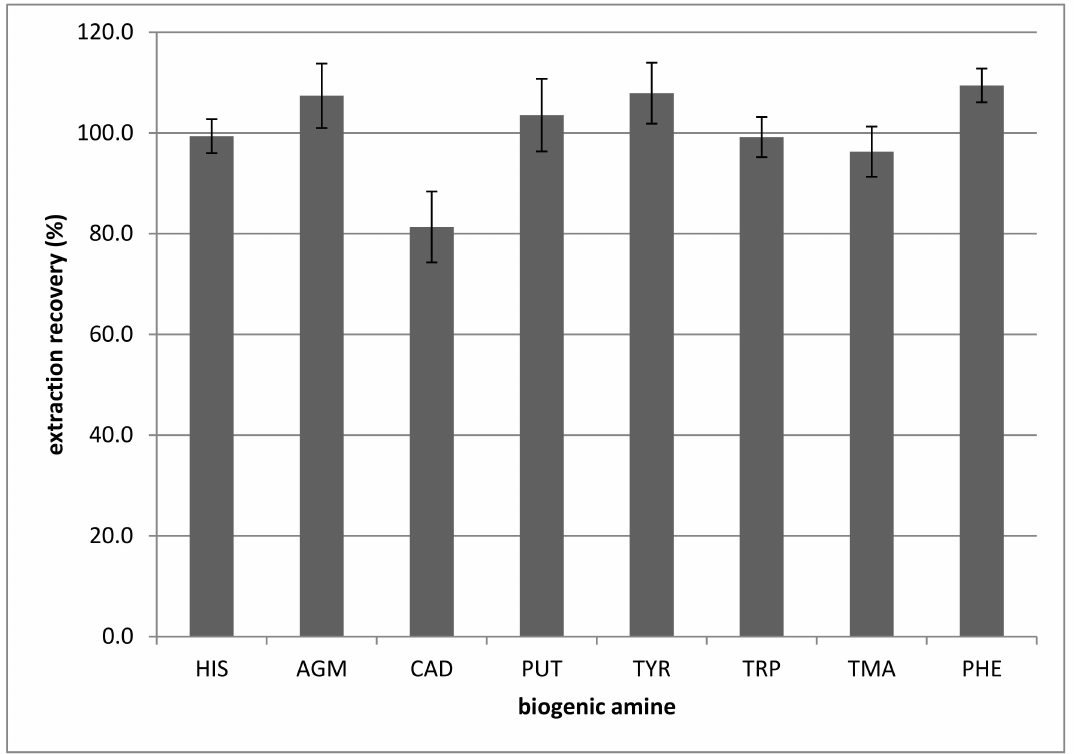
Figure 5. Extraction recoveries for some biogenic amines using the extraction method described in Section 2. HIS: Histamine, AGM: Agmatine, CAD: Cadaverine, PUT: Putrescine, TYR: Tyramine, TRP: Tryptamine, TMA: Trimethylamine, 2-PHE: